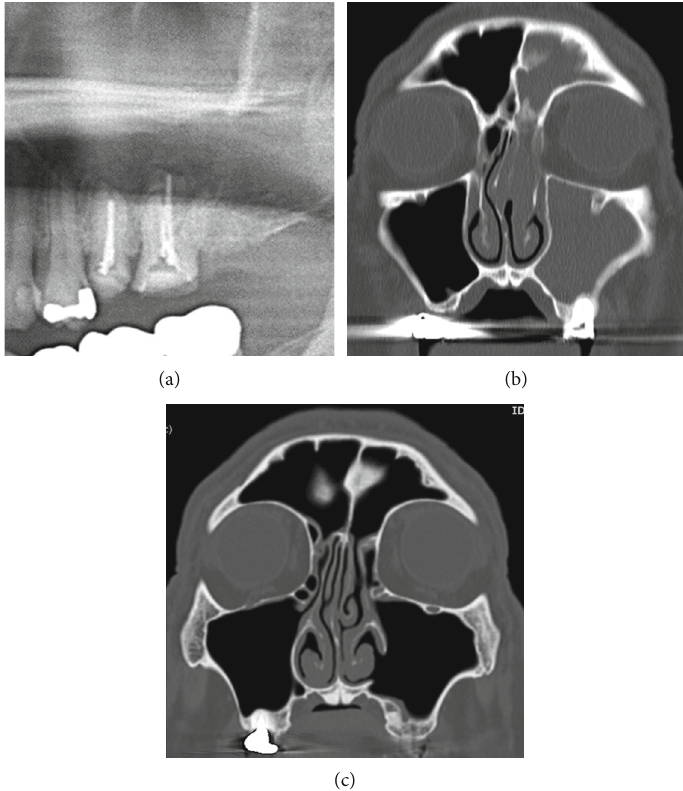
Figure 1: Radiographic fi ndings. (a) Panoramic radiograph taken after the endodontic treatment of teeth #25 and #26 showing complete obturation of the roots except for the buccal distal root canal of #26. (b) Frontal plane of the preoperative computerized tomography (CT) scan revealed opacity extending from the left maxillary sinus to the left frontal sinus. (c) Frontal plane of the postoperative CT scan showed patency of the nasoantral window and the clearness of the left maxillary sinus and the left frontal sinus two years